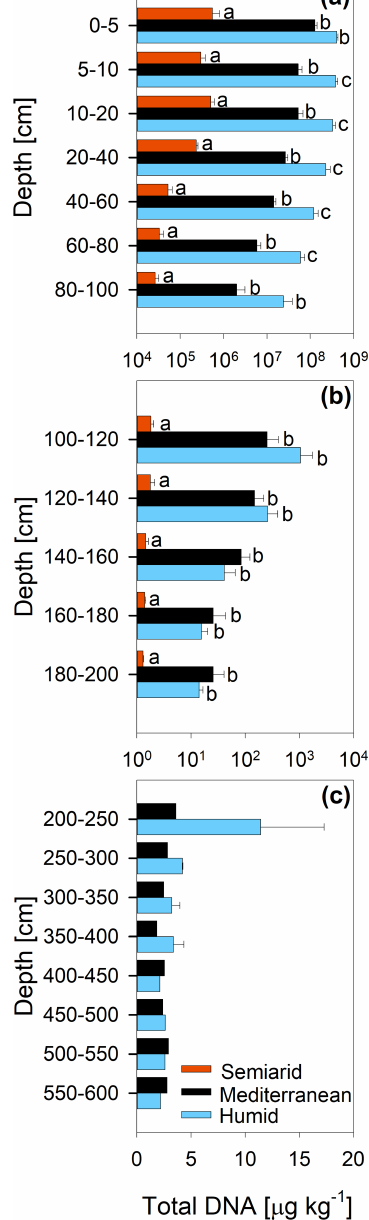
Figure 4. Total DNA content (mean ± standard error) of soil depth increments down to (a) 100cm, (b) 200cm, and (c) 600cm depth at three sites (arid, mediterranean, humid) located along a precipi- tation gradient in the Coastal Cordillera of Chile (0–200cm: n = 3, except for humid site with n = 4; > 200cm: n = 1, except for hu- mid site 200–400cm with n = 2). Please note the differences in the scale of the x axes with a logarithmic scale for (a) and (b) and a linear scale for (c) . Different letters indicate significant differences ( p ≤ 0 . 05) between the three sites tested by Tukey’s post hoc test after two-way